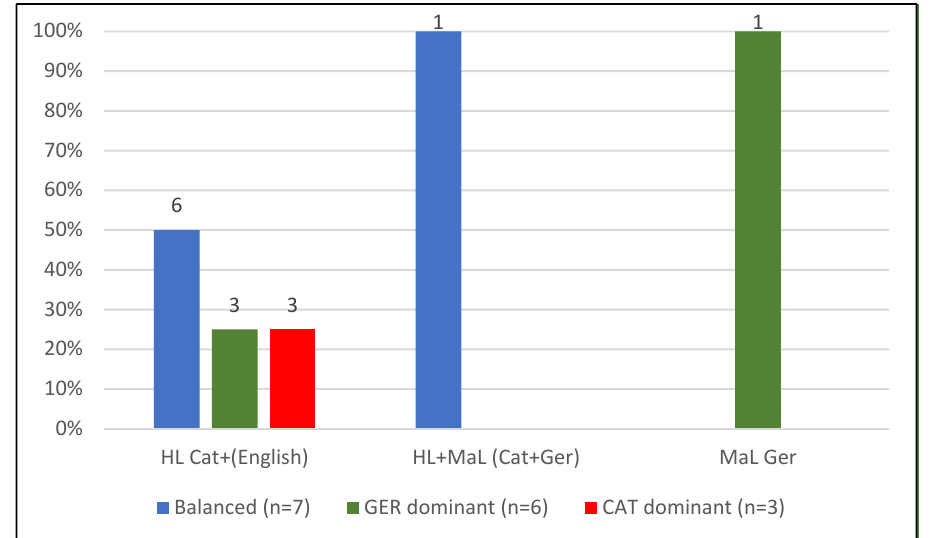
Figure 5. Children’s language dominance and child’s language to the Catalan-speaking parent.